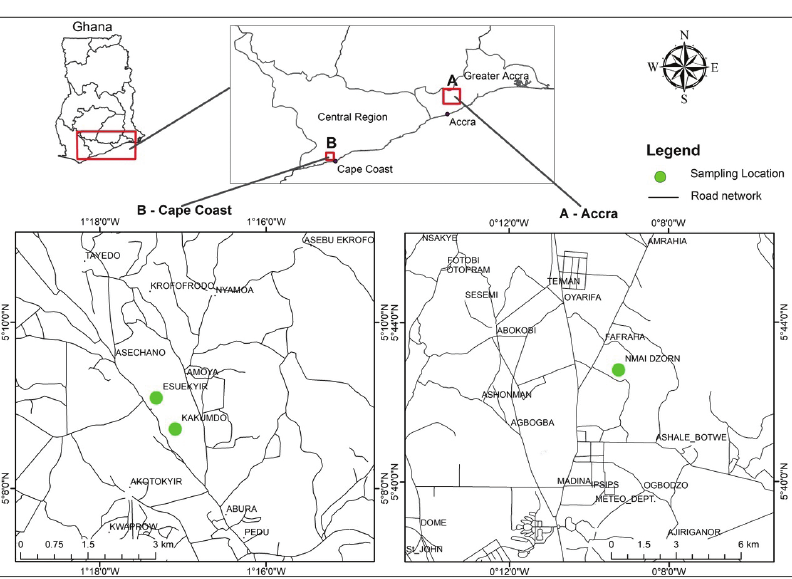
Figure 2. Map of Ghana showing regions, districts and study